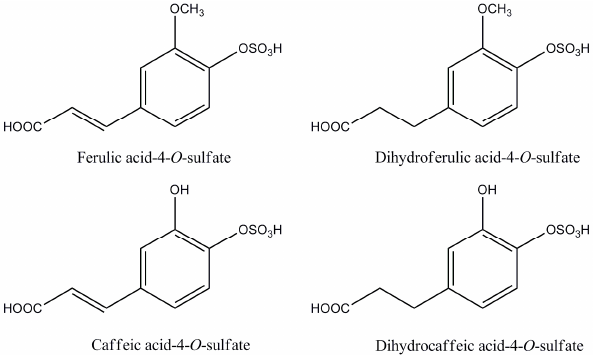
Figure 1. Chemical formulas of ferulic, caffeic, dihydroferulic and dihydrocaffeic acid sulfate me- tabolites.